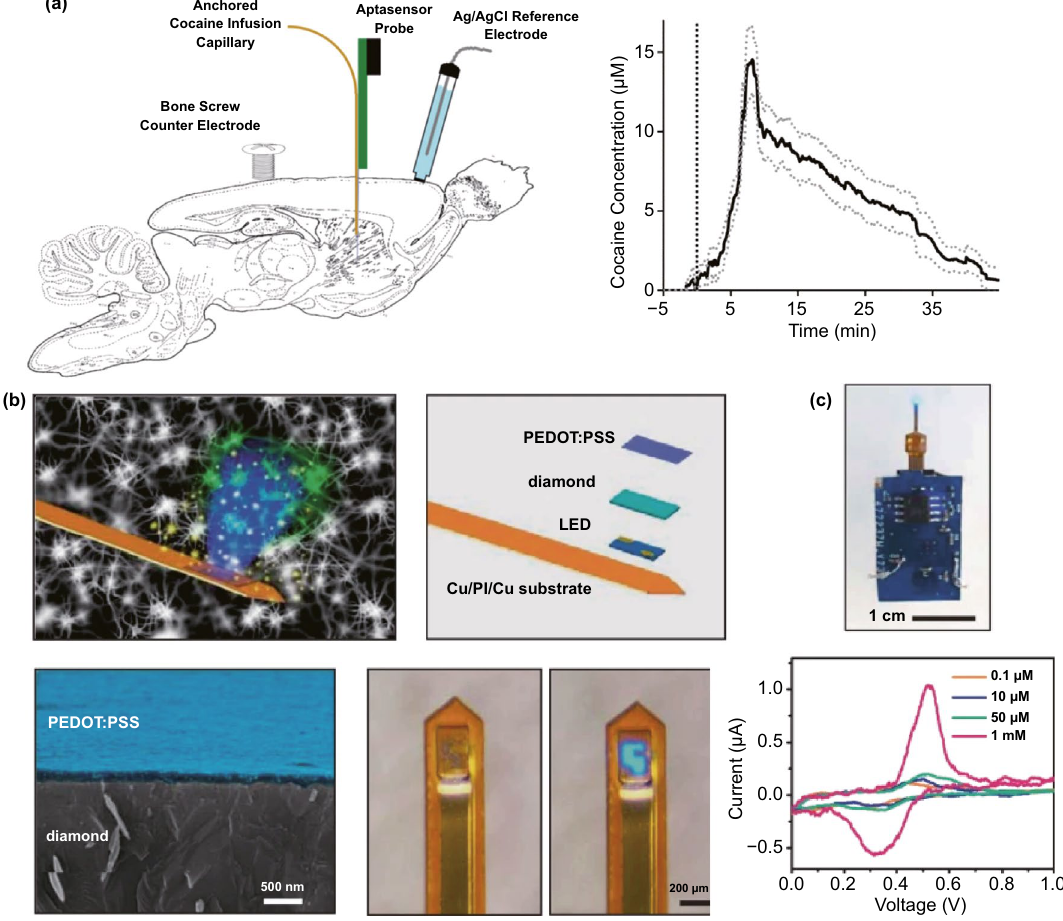
Fig. 20 Semi‑implantable electrochemical sensor for brain in vivo. a (left) Representative sagittal plots of in vivo experimental designs for cocaine detection experiments. (right) In vivo detection of systemic I.V. cocaine injection [348]. b Schematic diagram of an implantable micro‑ probe. c Photographs of implantable probes and CV curves in HCl solutions with different dopamine levels [347]. Reproduced with permission from Refs. [347, 348], copyright (2020) Nature Publishing Group and (2017) The Royal Society of Chemistry Publishing